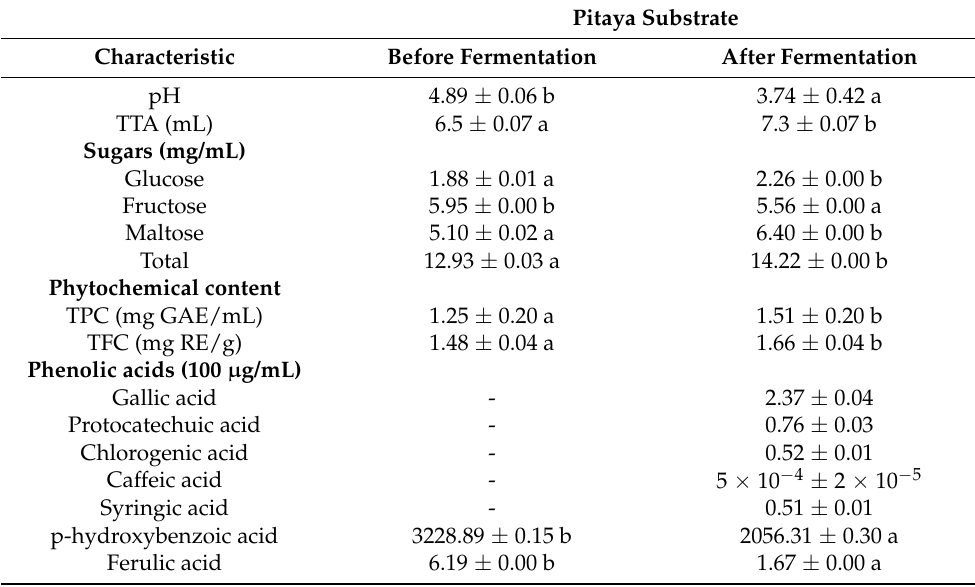
Table 1. Physicochemical properties, sugar composition and phenolic acid content in white pitaya substrate fermented by P. pentosaceus .